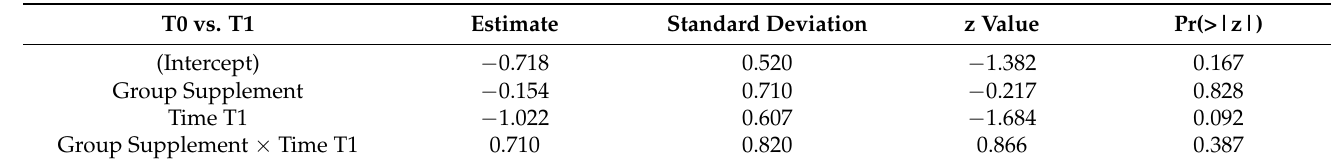
Table 3. Best “Effect” Estimate of Effusion. Fixed effects from multilevel model of effusion at times T0 vs. T1.